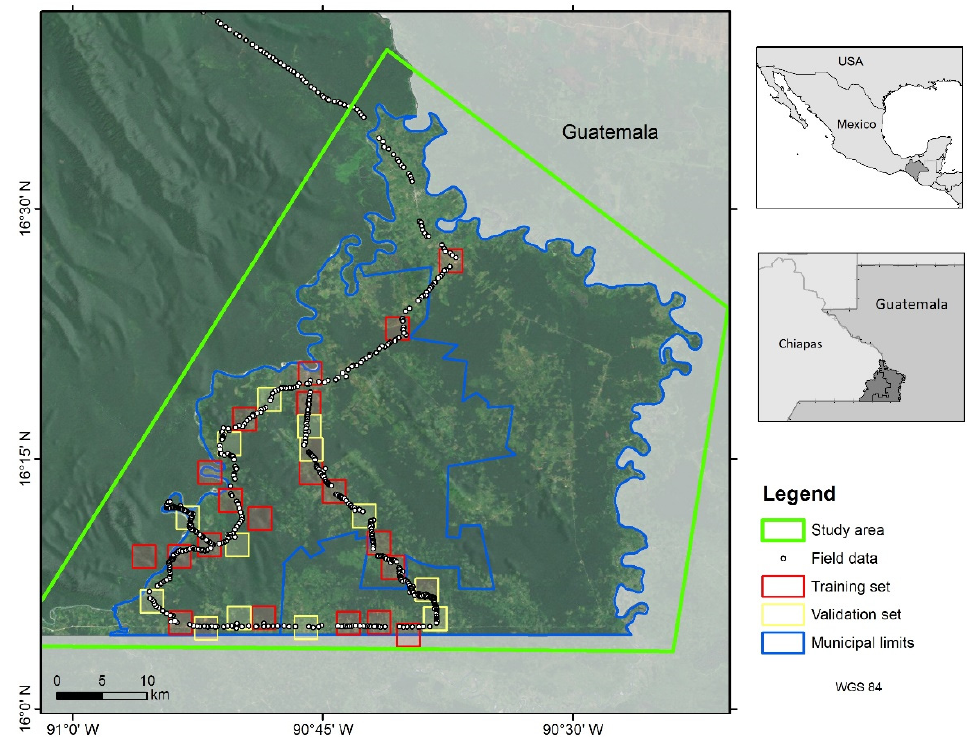
Figure 1. Study site location. Additionally, the in-field LULC data locations, as well as the training and validation areas are shown.